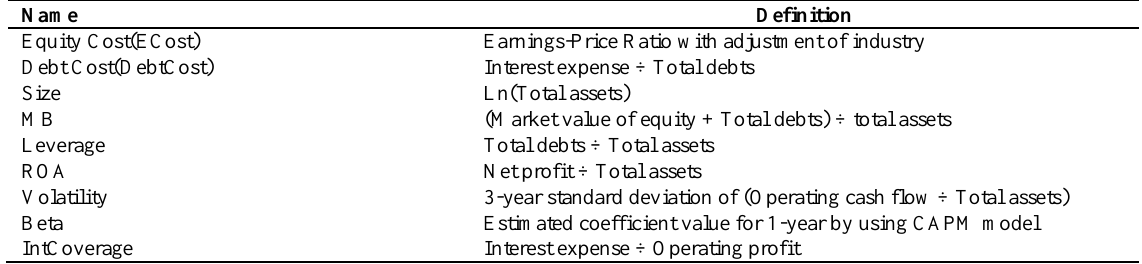
Table 1: Definition of variables